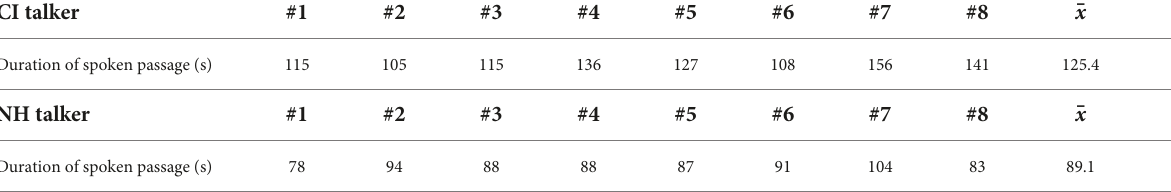
TABLE 1 Duration of the stimuli.